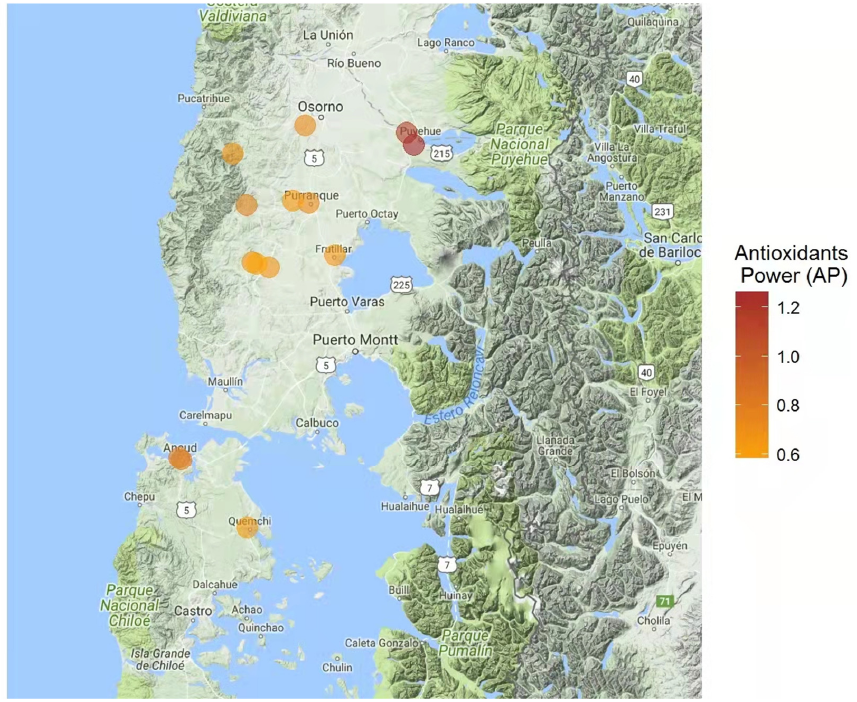
Figure 2. Map of the Los Lagos Region (Chile, 39 ◦ 16 (cid:48) S to 44 ◦ 04 (cid:48) S) indicating the sampled hive locations and respective antioxidant power of honey samples (mg of ascorbic acid equivalents/g of sample). Antioxidant power is indicated by a color scale going from light orange (lower power) to dark orange (higher